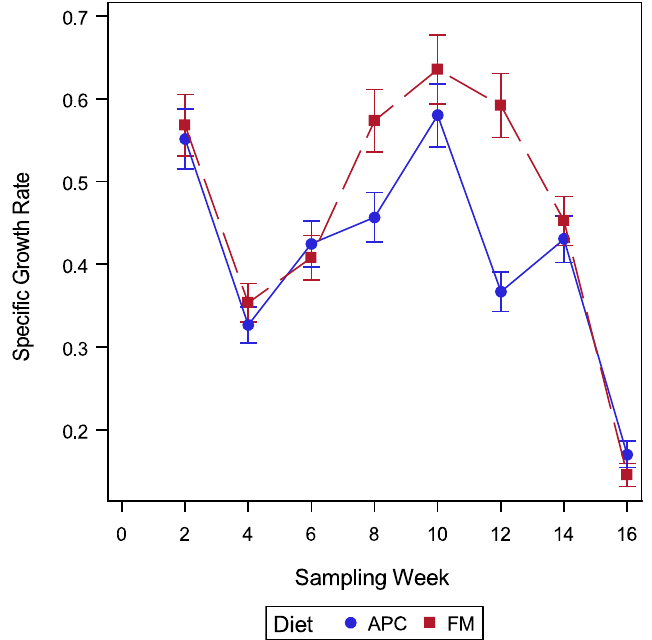
Figure 2. Specific growth rate for yellow perch averaged over the 16- and 14-week trials in 2017 and 2018, respectively. Values are means for each treatment (n = 8 for weeks 2–14 and n = 4 for week 16) ± standard error. No significant differences were measured between means at each week (alpha = 0.05). The treatments were isonitrogenous balanced diets with either 180 g/kg alfalfa protein concentrate (APC; solid blue line) or 150 g/kg fishmeal (FM; dashed red line). Diet affected moisture content of the yellow perch fillets in a small but measurable amount. Fish on the APC diet had 79.3% moisture content in the fillet as opposed to 78.9% moisture in fillets from fish on the fishmeal diet (Table 3; p = 0.05). Protein, lipid, ash, and